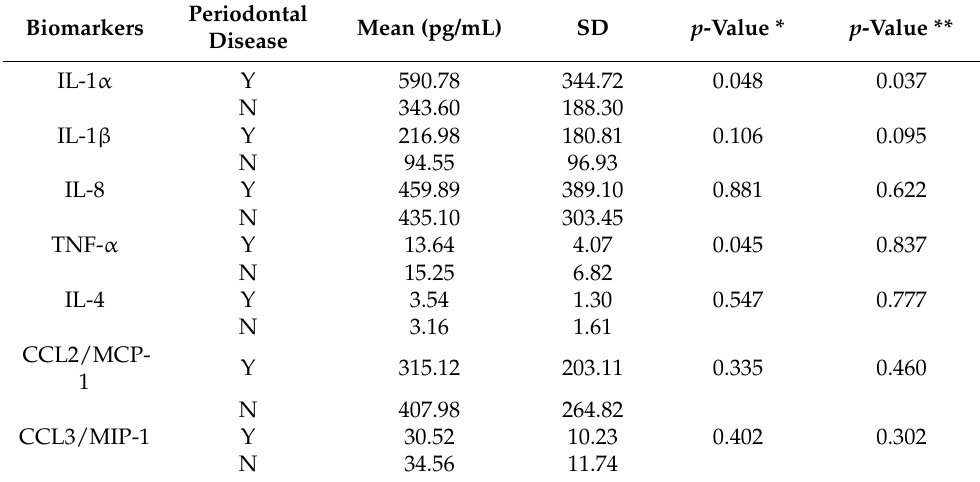
Table 3. Salivary cytokines associated with periodontal